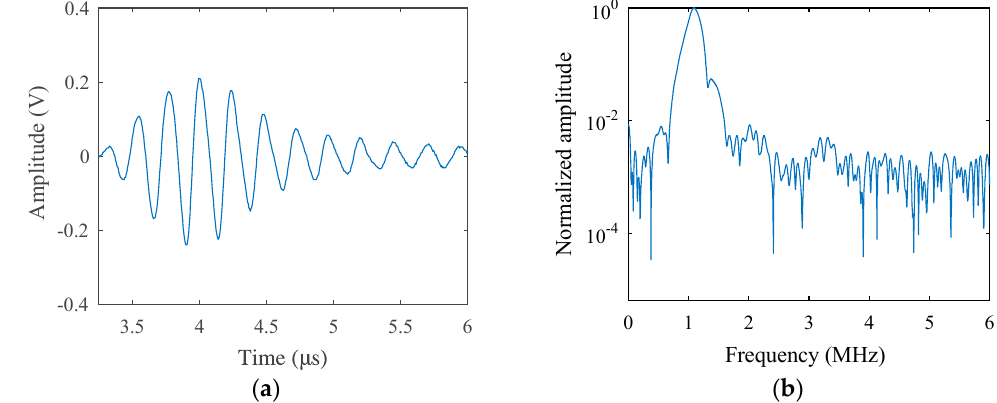
Figure 7. ( a ) Transmitted signals received from the fatigue sample (Loading Cycle 0) in the time-domain and ( b ) in the frequency-domain (excitation voltage 200 V).